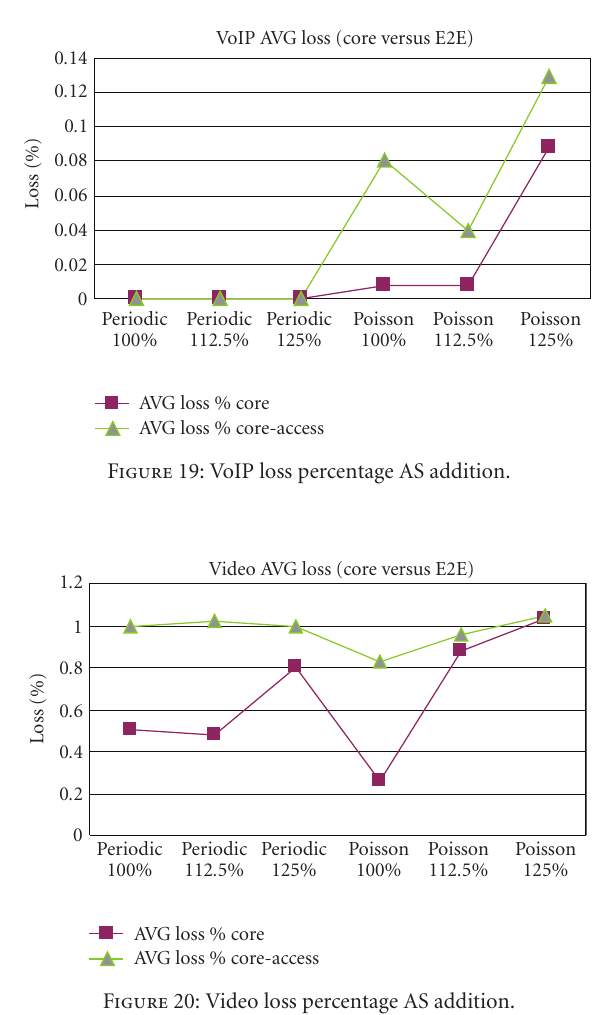
Figure 20: Video loss percentage AS addition.